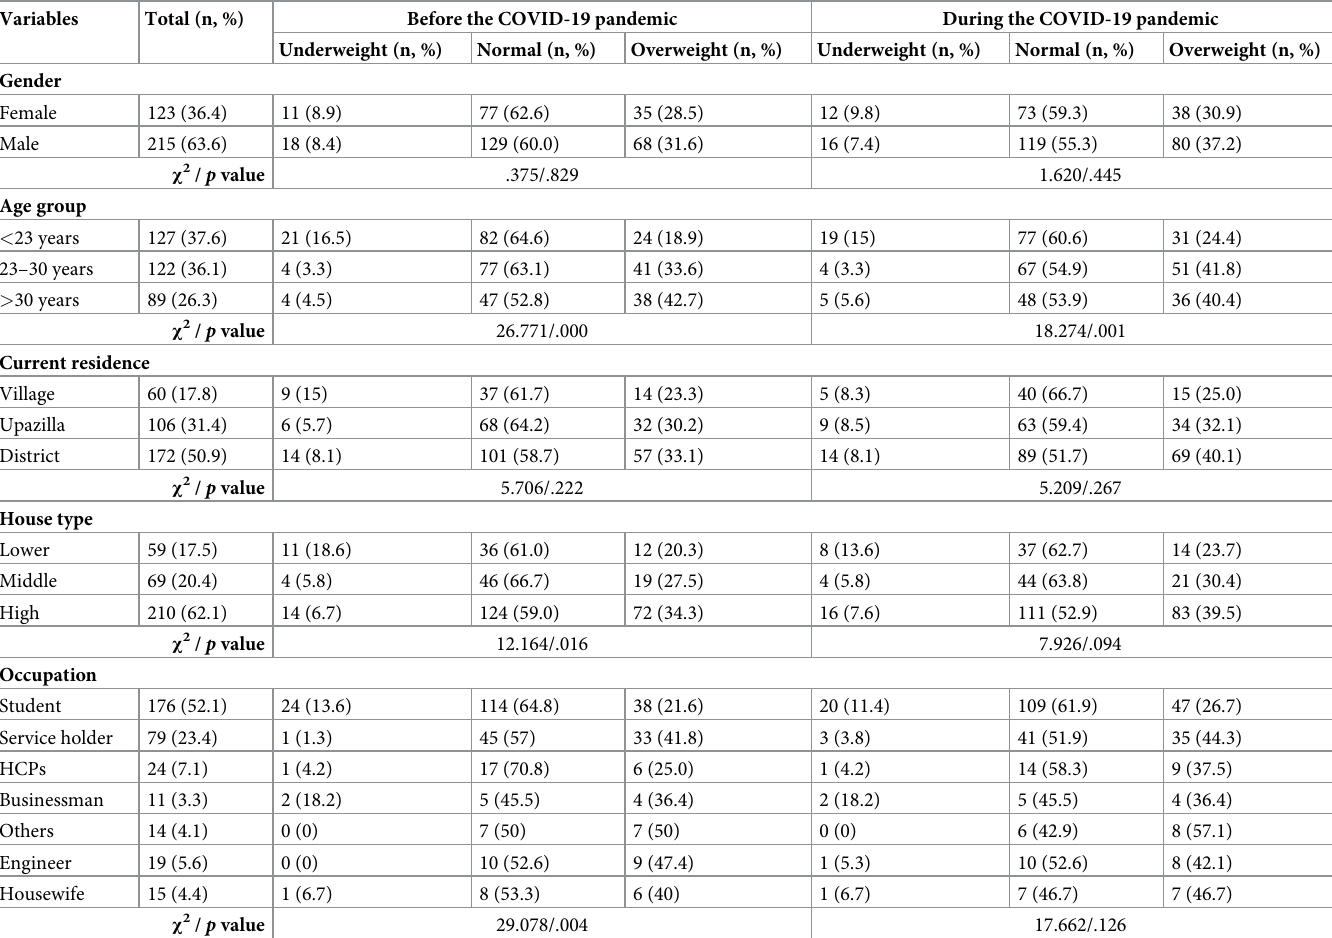
Table 1. Associations between socio-demographic variables and BMI